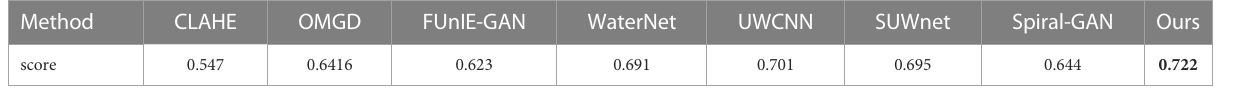
TABLE 7 The result of mutual information.